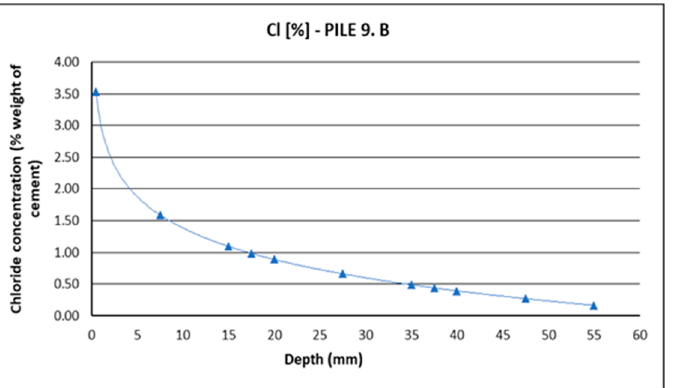
Figure 5. Chloride profile showing the chloride concentration as a function of depth in the test sample.